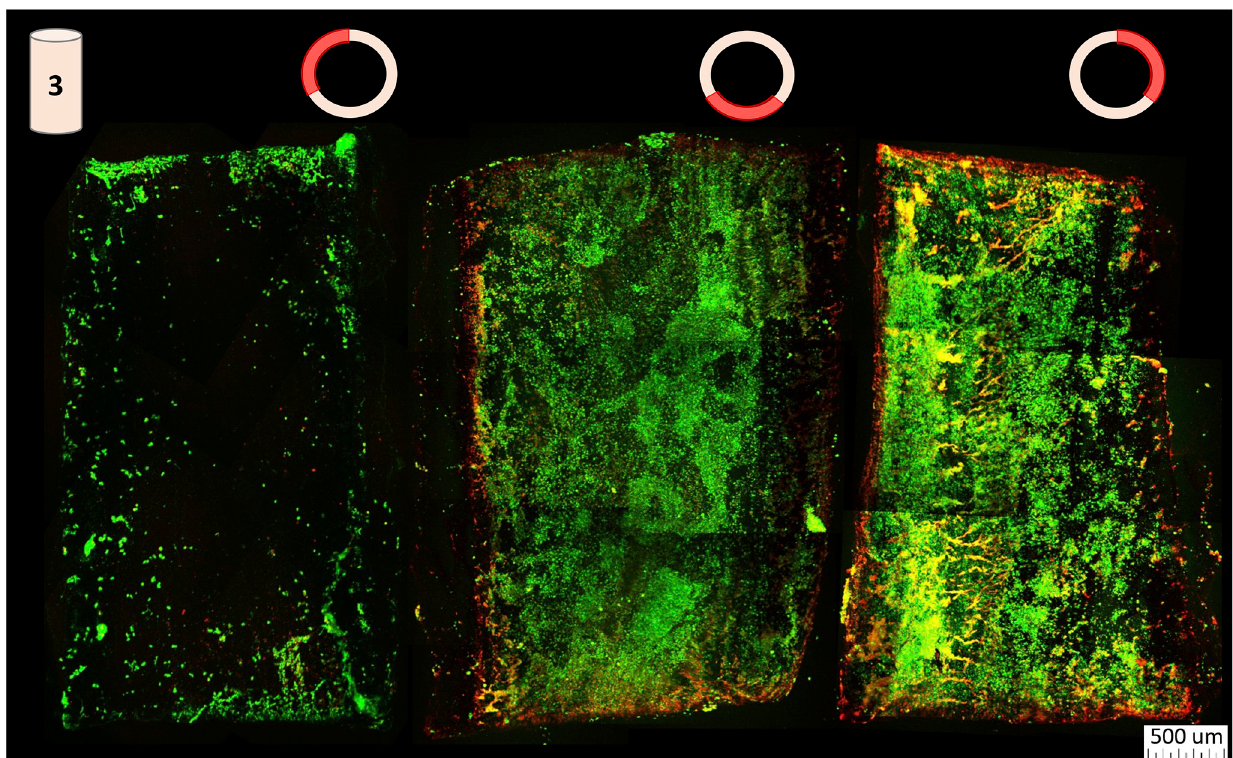
Fig 4. Spatial live/dead cell imaging. The middle section of a perfusion seeded scaffold is represented in 3rds. The left most portion is the top right edge of the scaffold, the middle portion is the bottom of the scaffold, and the right most portion is the top left side of the scaffold. Each section length was approximately 5 mm, and its circumference was 6.28